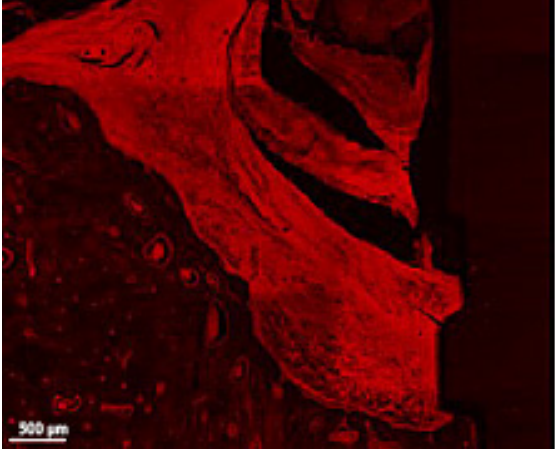
Figure 7. Detail of the soft tissue and bone in a thick section of a ligated implant. Note the presence of ligatures in the upper central region of the image, the highly inflamed soft tissue in contact with bone and implant surface, the minimal presence of Howship lacunae and the congested venules (implant #5, buccal aspect, bar, 500 µm).